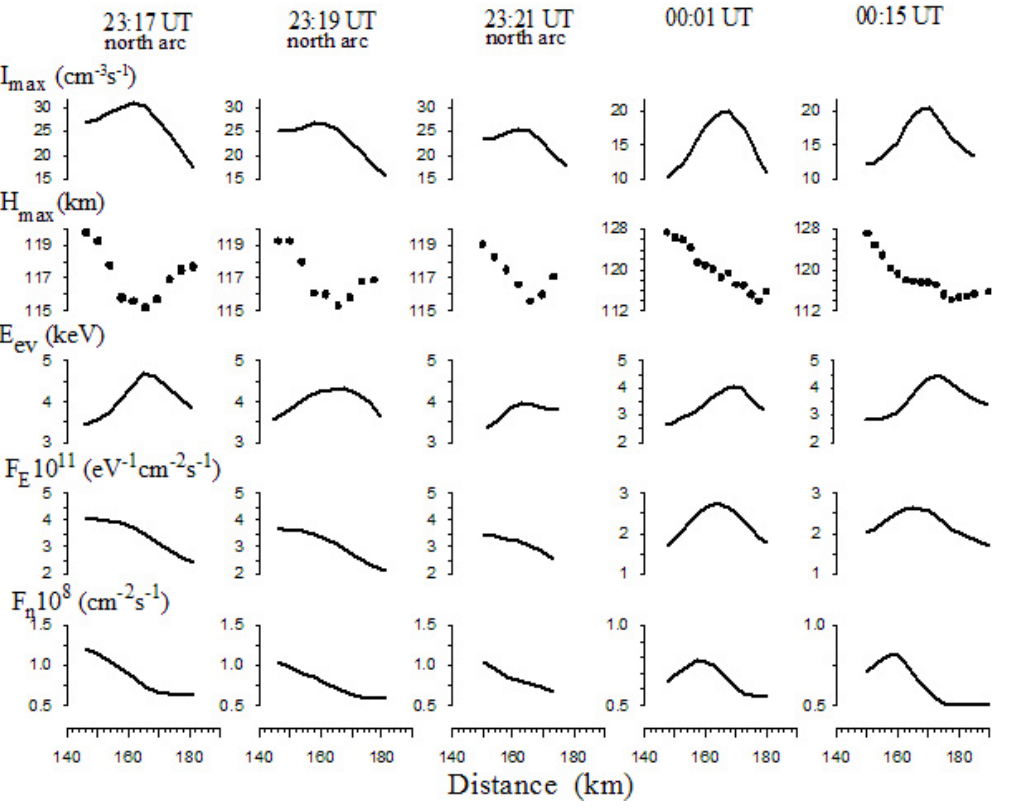
Fig. 8. Meridional behavior of auroral emission intensity characteristics and parameters of the precipitating electron flux inside the individual